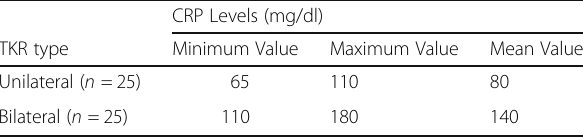
Table 2 Observations made on the 2nd postoperative day CRP Levels (mg/dl)